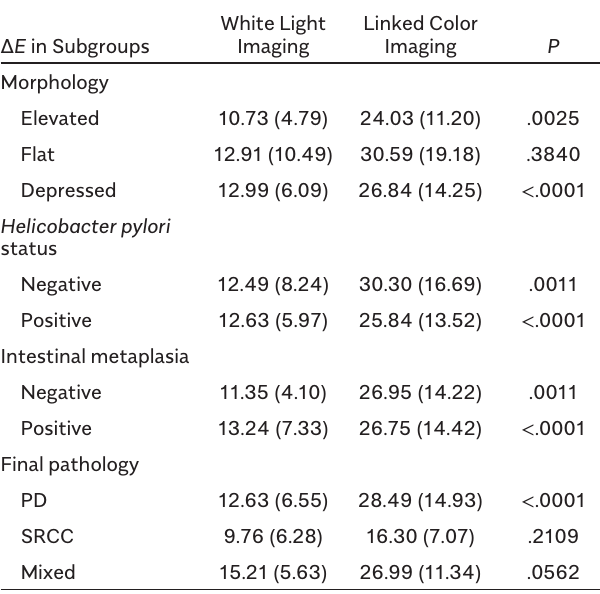
Table 3. Color Differences Between Cancerous Lesions and the Non-cancerous Mucosa with White Light Imaging and Linked Color Imaging in Pre-specified Subgroups White Light Δ E in Subgroups